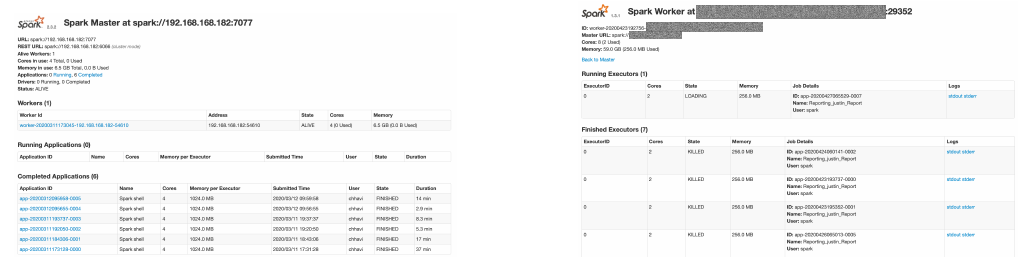
Figure A9. Apache Ambari (left) and Kibana (right) servers.